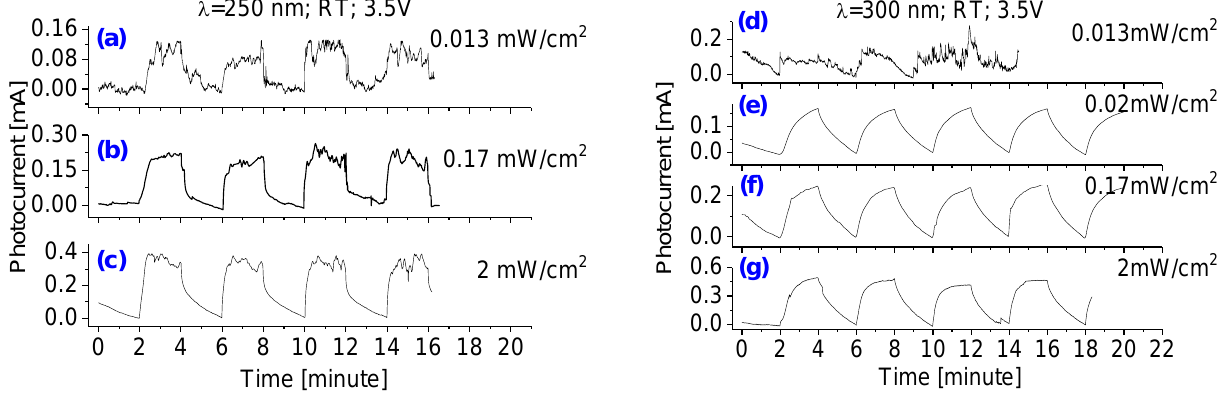
Figure 6. The measured photocurrents when illuminated with 250 nm of ( a ) 0.013 mW/cm 2 , ( b ) 0.17 mW/cm 2 , ( c ) 2 mW/cm 2 , and when illuminated with 300 nm of ( d ) 0.013 mW/cm 2 , ( e ) 0.02 mW/cm 2 , ( f ) 0.17 mW/cm 2 and ( g ) 2 mW/cm 2 , respectively. The device was operated at room temperature and biased at 3.5 V.